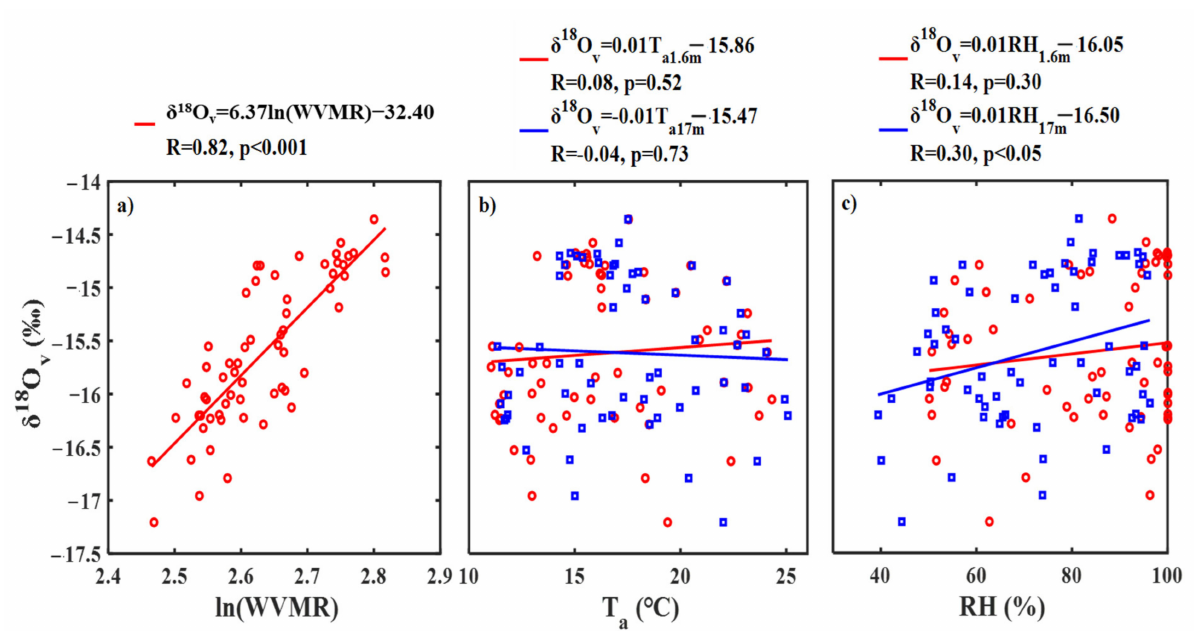
Figure 6. Relationships between water vapor δ 18 O at 17 m ( δ 18 O v ), and ( a ) the log value of water vapor mixing ratio (ln (WVMR)), ( b ) air temperature at 1.6 m (T a1.6m ) and 17 m (T a17m ), and ( c ) relative humidity (RH) at 1.6 m (RH 1.6m ) and 17 m (RH 17m